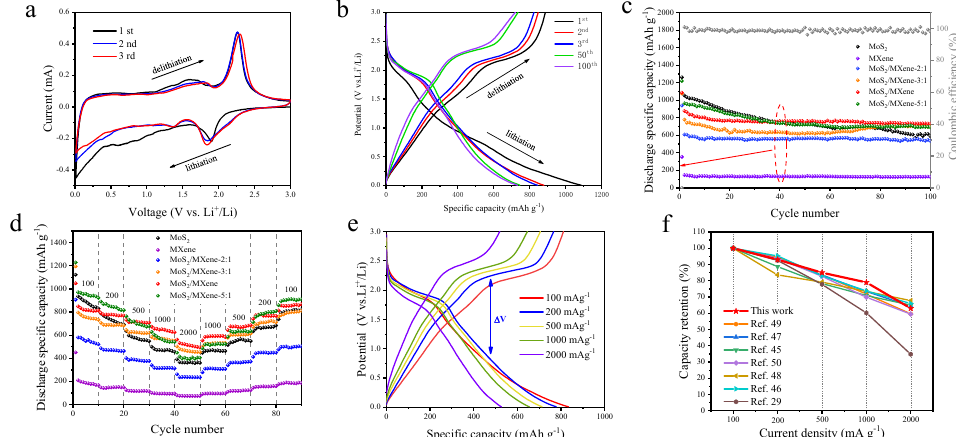
Figure 3. ( a ) CV curves of MoS 2 /MXene at the scan rate of 0.1 mV s − 1 ; ( b ) charge/discharge profiles of MoS 2 /MXene at 100 mA g − 1 ; ( c ) cycling performance of MoS 2 , MXene and MoS 2 /MXene − x:1 (x = 2, 3, 4, 5) at 100 mA g − 1 ; ( d ) rate performance of MoS 2 , MXene and MoS 2 /MXene − x:1 (x = 2, 3, 4, 5) at different current densities (100, 200, 500, 1000 and 2000 mA g − 1 ); ( e ) charge/discharge profiles of MoS 2 /MXene electrode at different current densities; ( f ) comparison of the capacity retention of as-prepared MoS 2 /MXene with other related materials.